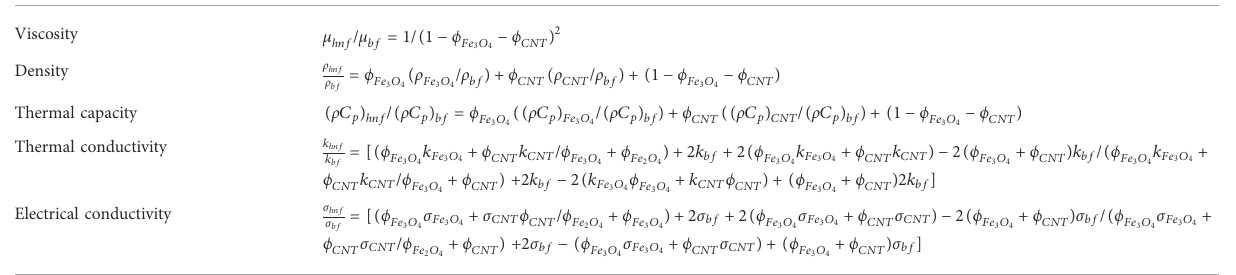
TABLE 2 Thermo-physical relations of hybrid nano fl uids (Gul et al., 2020). Properties